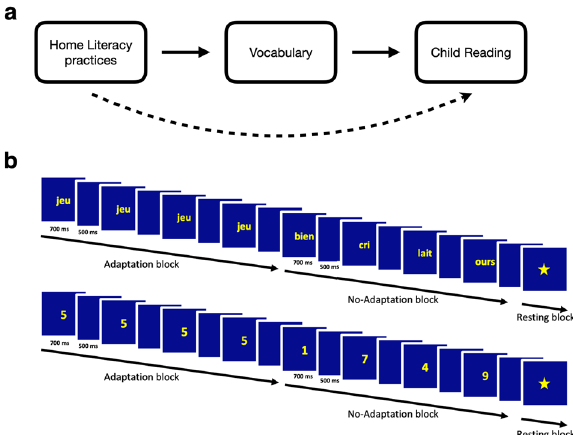
Fig. 1 Model and experimental design. a Hypothesized model of the relations between home literacy practices, vocabulary and reading. b Experimental task. Participants were sequentially pre- sented with words (top) or digits (bottom) that were identical (adaptation blocks) or different (no-adaptation